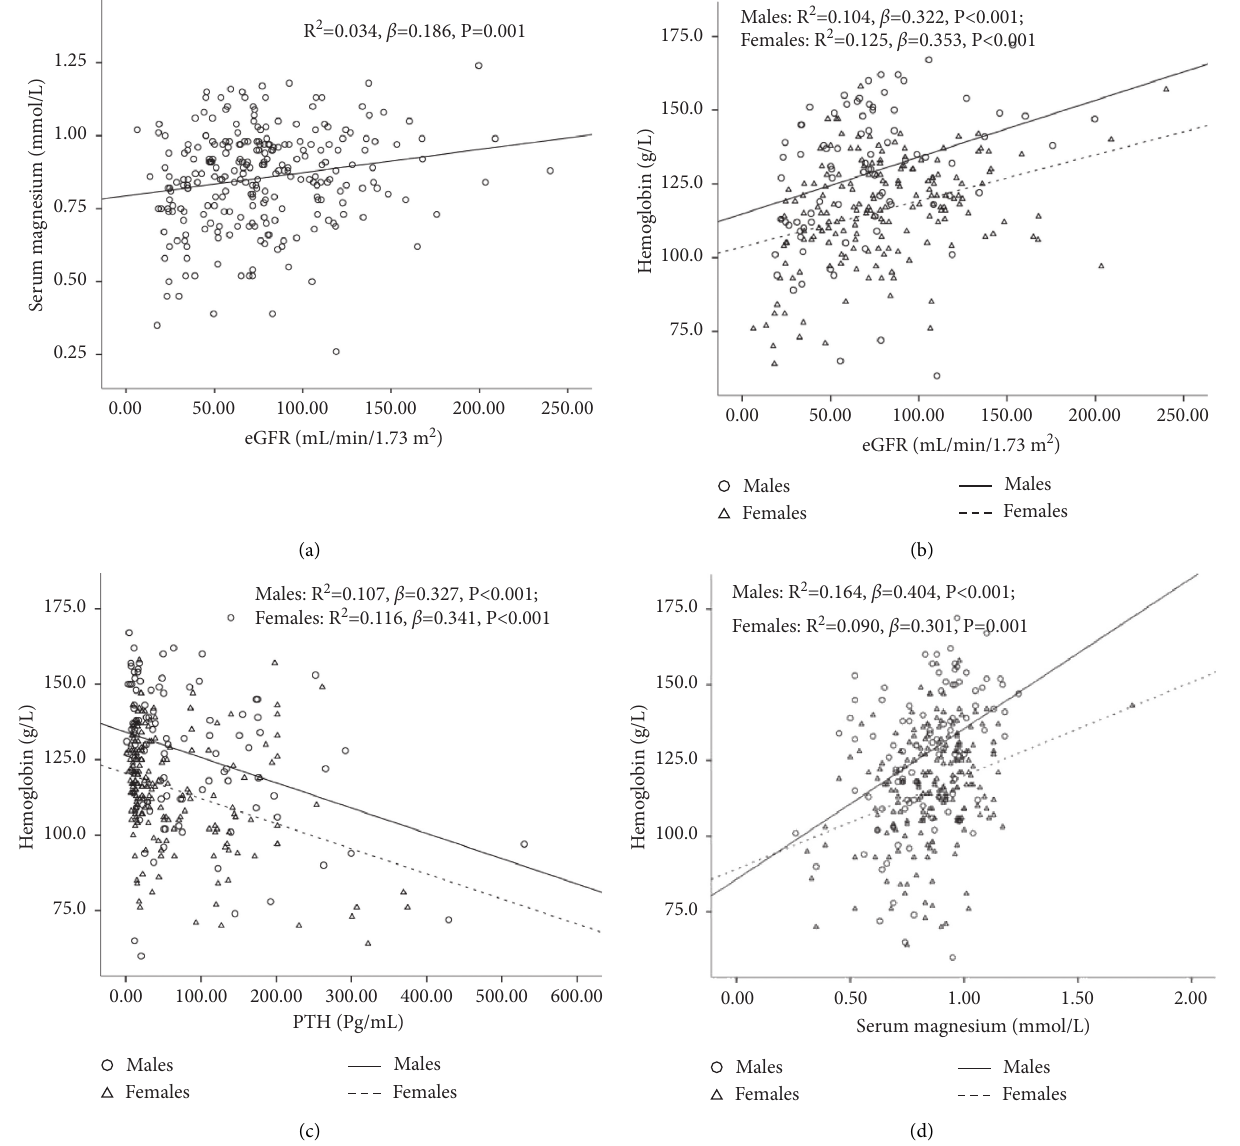
Figure 1: Relationship between serum hemoglobin/magnesium and various indicators in patients with PHPT.